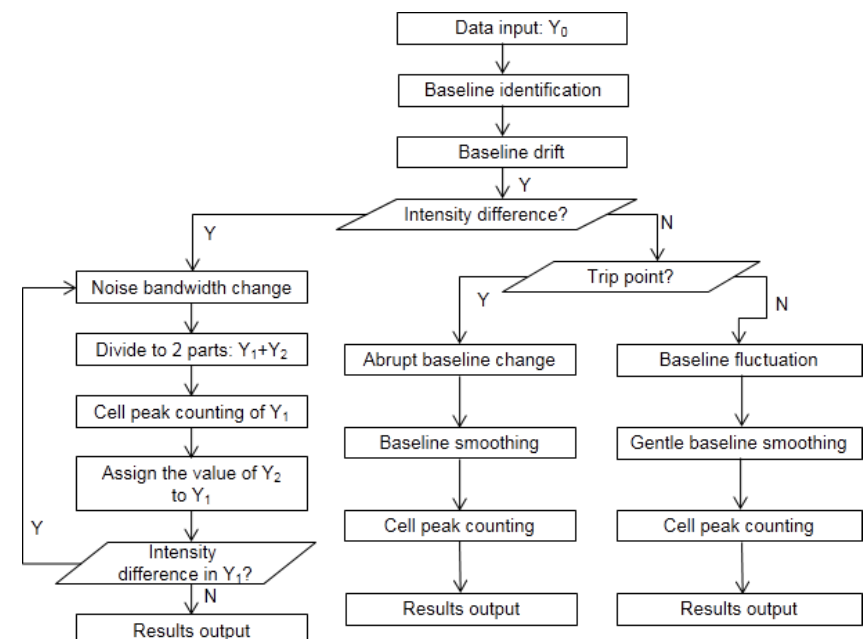
Fig. 3. Flow chart of the processing method. Concrete operations of baseline correction method are described as follows: using the interpolation ¯tting method to get a curve that is denoted as baseline level. By subtracting the original signal with the baseline level, we can get the corrected signal with a less °uctuating baseline level. Check if there is any trip point in the corrected signal, and then check if there is intensity di®erence between both sides of the trip point. Count cell peaks according to the formula and output results both in ¯gure and text